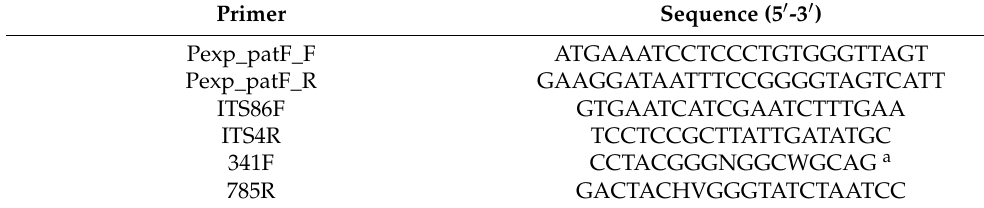
Table 1. List of primers used in this